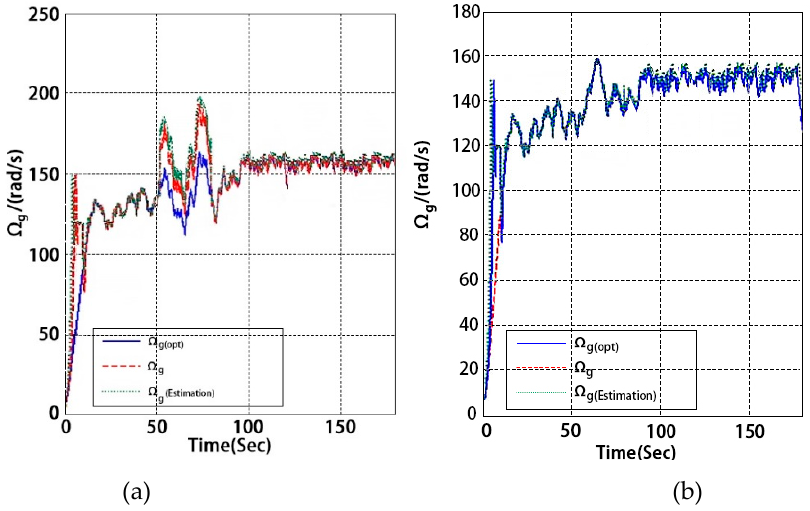
Ω . (a) Without using the FRSFTC strategy; (b) Using the FRSFTC r